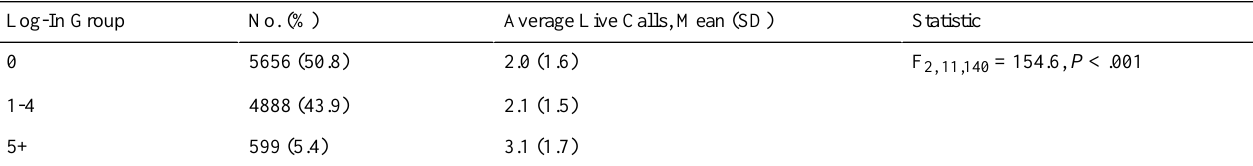
Table 3. Web utilization and average calls completed, by Web Coach log-in group (N = 11,143)